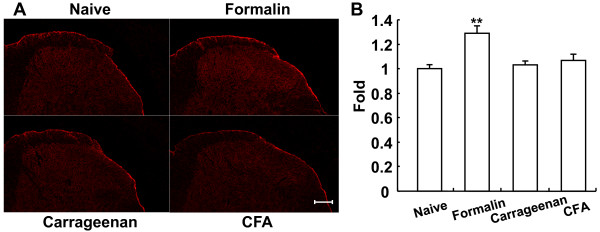
Nitrosocysteine immunoreactivity in the spinal cord of inflammatory pain models. A. Immunoreactivity of nitrosocysteine in the spinal cord. Lumbar transverse sections (20 μm) of spinal cords prepared from before and 5 min, 6 h, and 24 h after injection of formalin, carrageenan, and CFA, respectively, were fixed and stained with anti-nitrosocysteine antibody as described in "Method". Bar = 100 μm. B. Quantification of S-nitrosocysteine immunostaining. Fluorescence intensity of the spinal cord was quantified by ImageJ. The intensity of the spinal cord in inflammatory pain models was normalized to that of naive mice, and the intensity (mean ± SEM, n = 23-24) of naive mice was taken as "1." **P < 0.01.